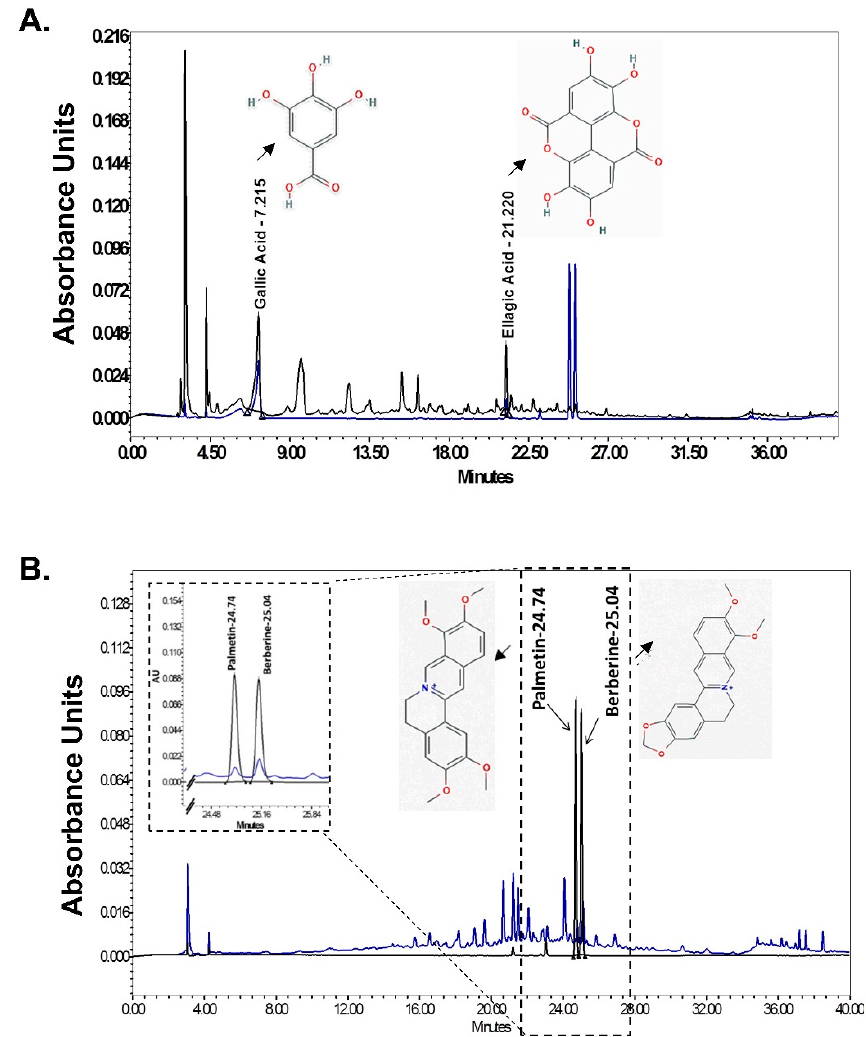
Figure 8. HPLC analysis identification of active ingredients in Denguenil. The Denguenil sample was crushed into a fine powder and analyzed on HPLC using reference standards. The chromatographs were recorded at 270 nm (gallic acid and ellagic acid) and 346 nm (palmetin and berberine) wavelength. By comparing with chromatographs of pure standards, HPLC analysis identified the presence of bioactive compounds, namely, ( A ) gallic acid and ellagic acid and ( B ) palmetin and berberine in the Denguenil. The chemical structures of the identified compounds have been appended in the chromatogram.